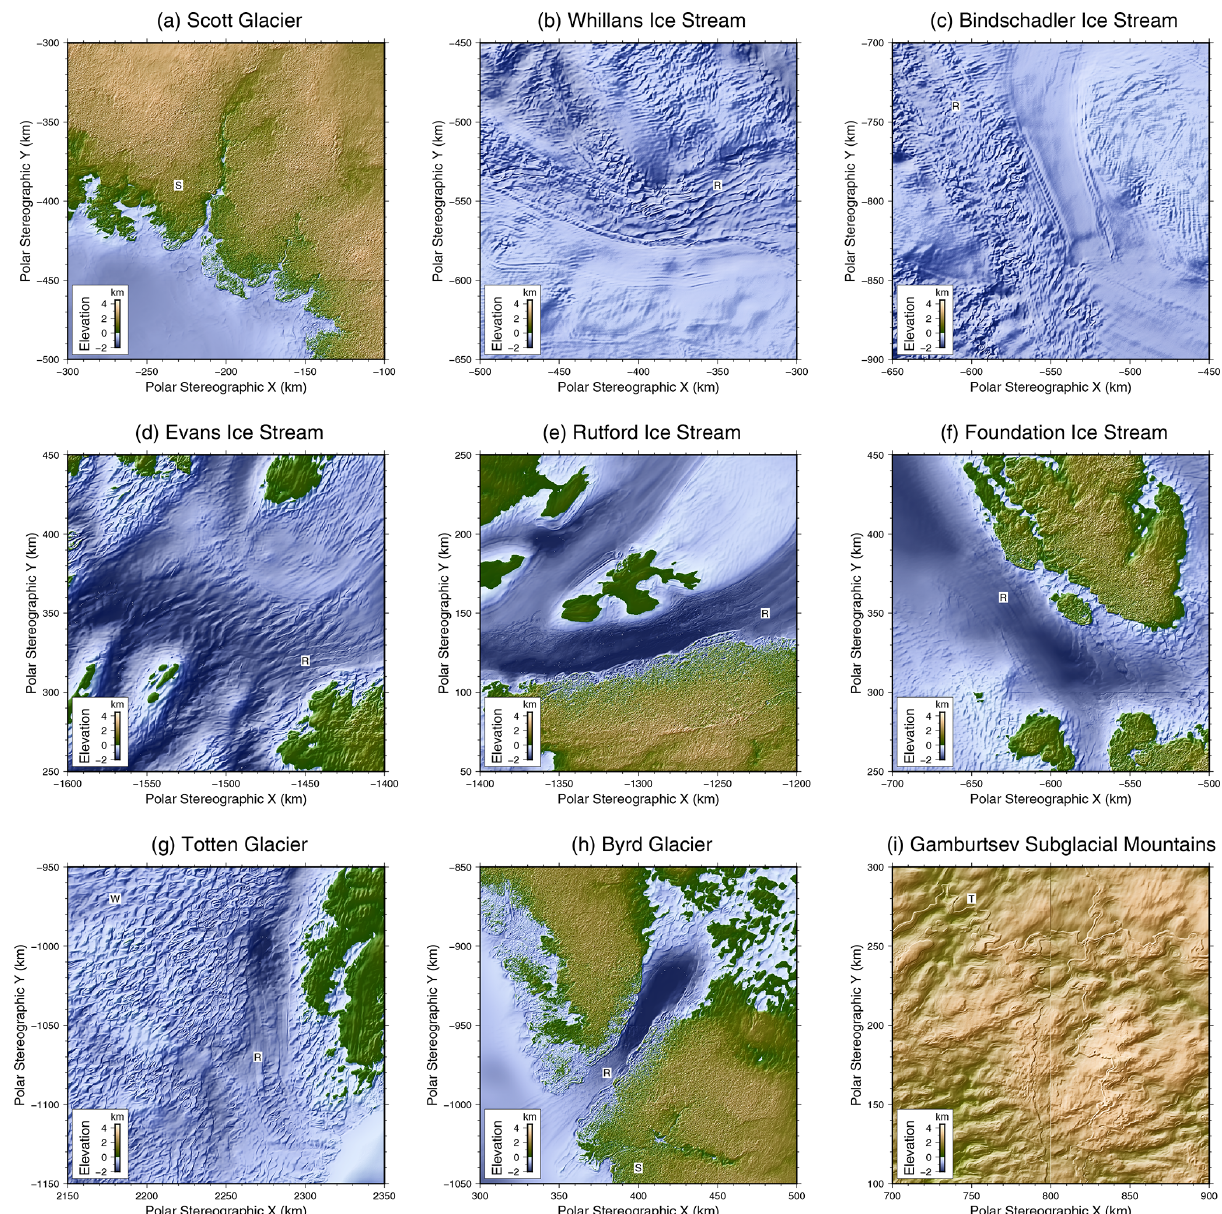
Figure 4. Close-up views of DeepBedMap_DEM around Antarctica. Panels (a–c) show Siple Coast locations. Panels (d–f) show Weddell Sea region locations. Panels (g–i) show East Antarctica locations. Features of interest are annotated in black text against a white background: ridges R, speckle patterns S, terraces T, wave patterns